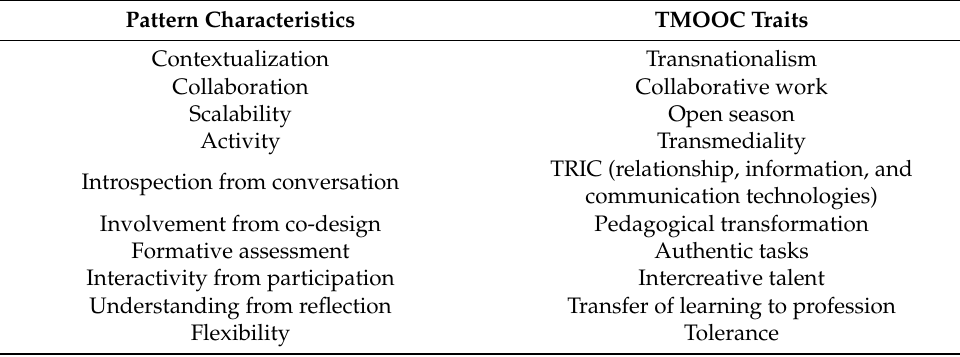
Table 1. Characteristics of the pedagogical pattern vs. features of the